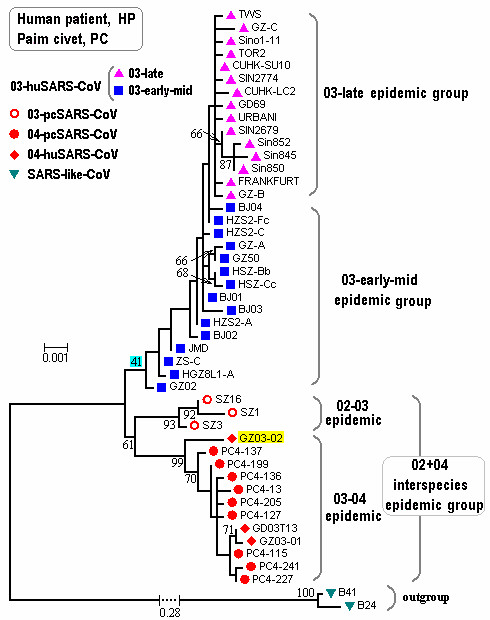
Phylogenetic tree of 47 S gene sequences from human patients and animals. The evolutionary process of S proteins during whole epidemic was simplified into three epidemic groups: 02–04 interspecies, 03-early-mid, and 03-late epidemic groups. Each group includes 15 unique S gene sequences after deleting all duplicate sequences (Table S1, see additional file 2). Two sequences isolated from bats were used as the outgroup in phylogenetic tree construction. The tree was constructed by the maximum likelihood method with 1000 bootstrap replicates using PHYML v2.4.4. Only the branch bootstrap values ≥ 50% are shown. PC, palm civet; HP, human patient.